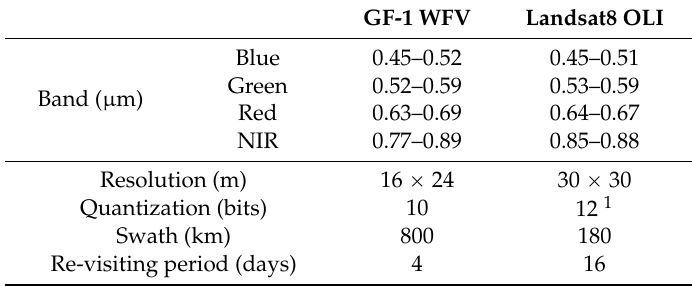
Table 1. Comparison of the parameters between Gaofen-1 WFV (Wide Field of View) and Landsat-8